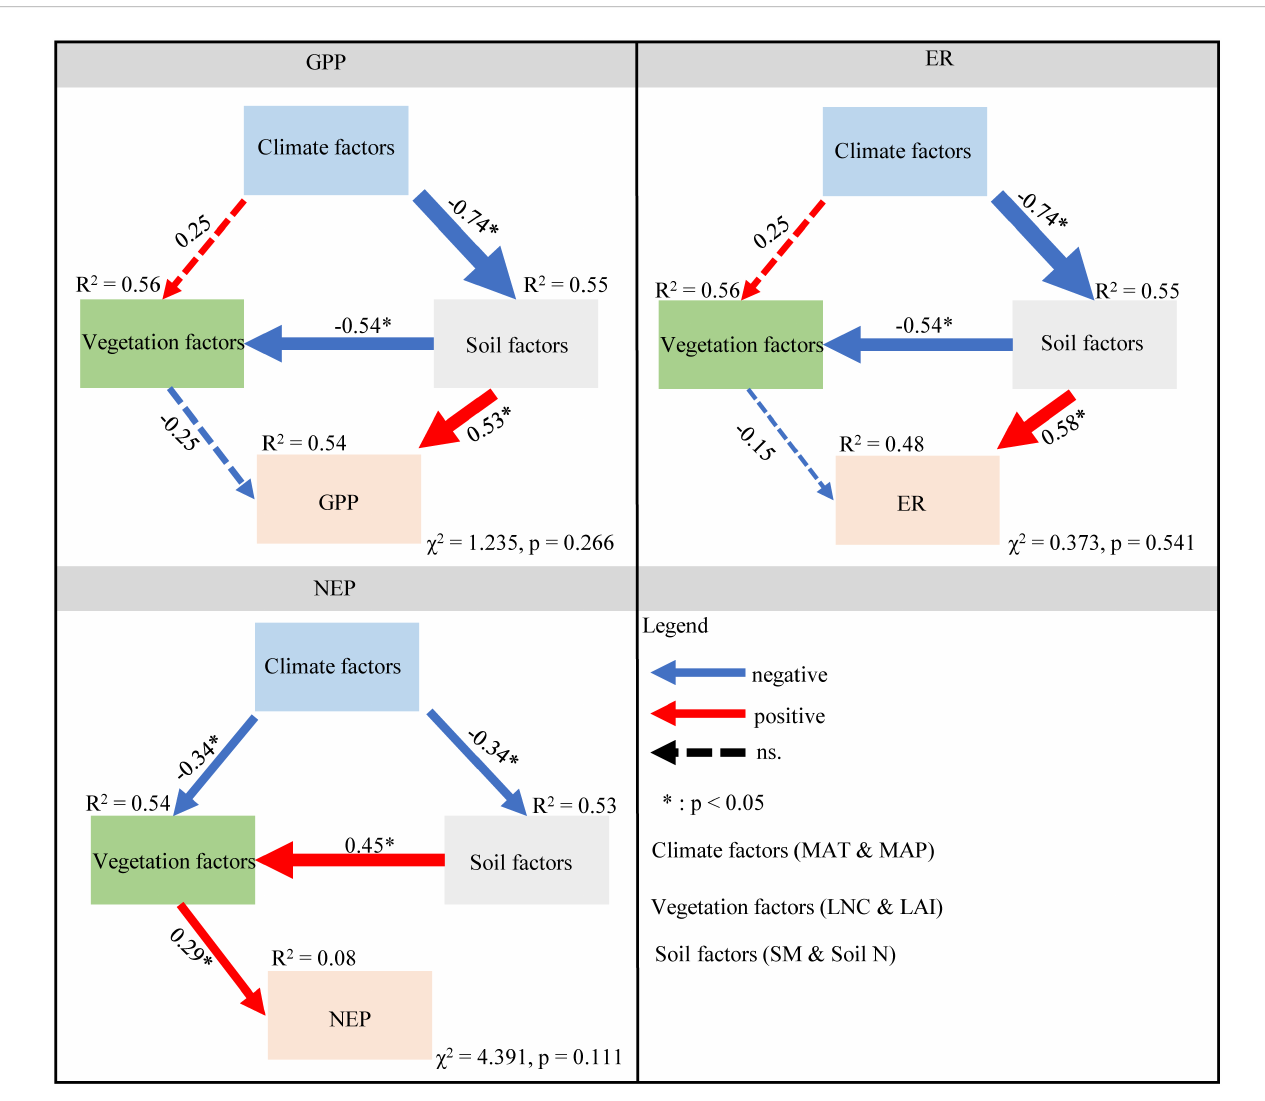
FIGURE 6 Structure equation modeling to explore the direct and indirect effects of climate, vegetation, and soil factors on GPP, ER, and NEP. The blue and red arrows indicate negative and positive relationships, respectively. The dashed line represents a nonsigni fi cant relationship (P > 0.05). The arrow width is proportional to the strength of the relationship. The numbers adjacent to the arrows are standardized path coef fi cients. The proportion of variance explained (R 2 ) appears alongside each response variable in the model. * indicates the signi fi cance level is less than 0.05. MAT, mean annual temperature; MAP, mean annual precipitation; LAI, leaf area index; Soil N, soil total nitrogen content; LNC, leaf nitrogen content; SM, soil moisture; NEP, net ecosystem productivity; GPP, gross primary productivity; ER, ecosystem